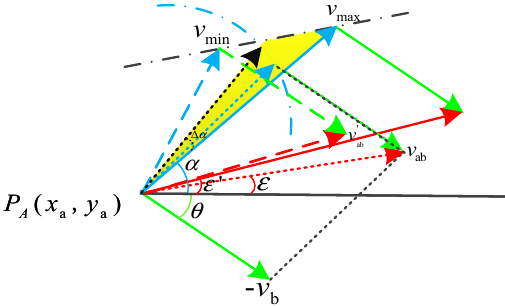
Figure 6. UAV composite relief solution set (shaded in yellow).